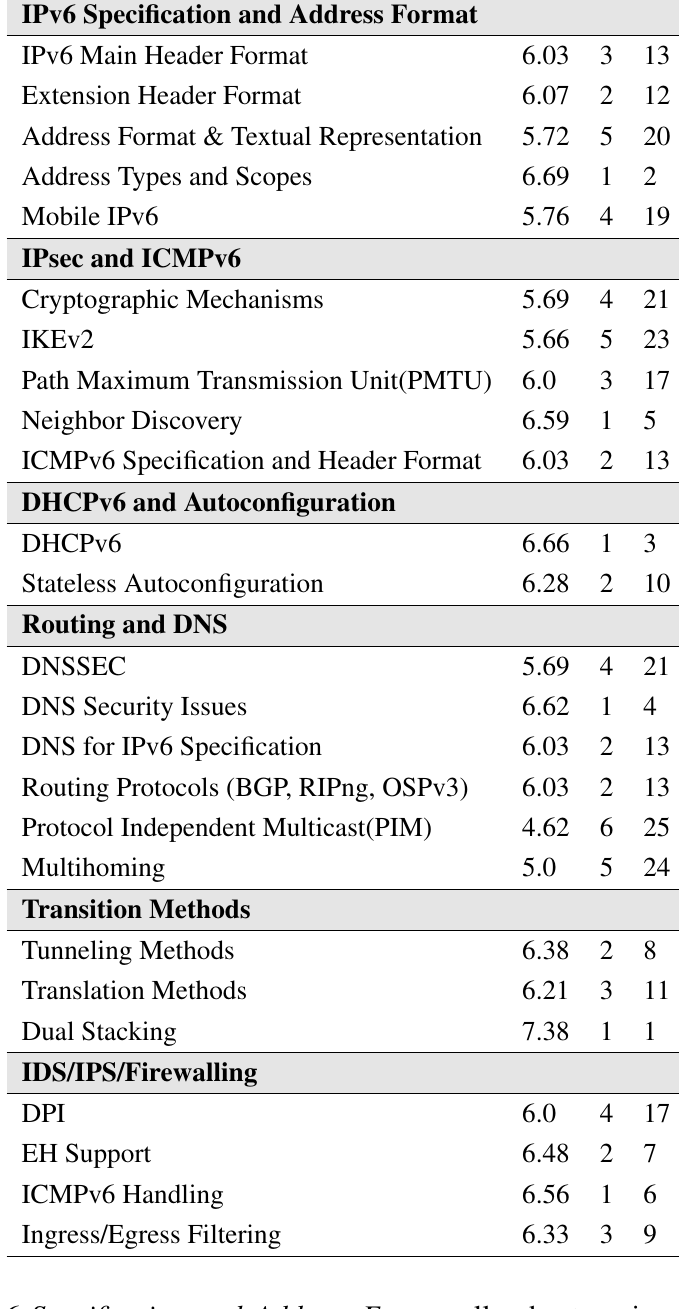
Table 5. Rating results for subcategories (n =